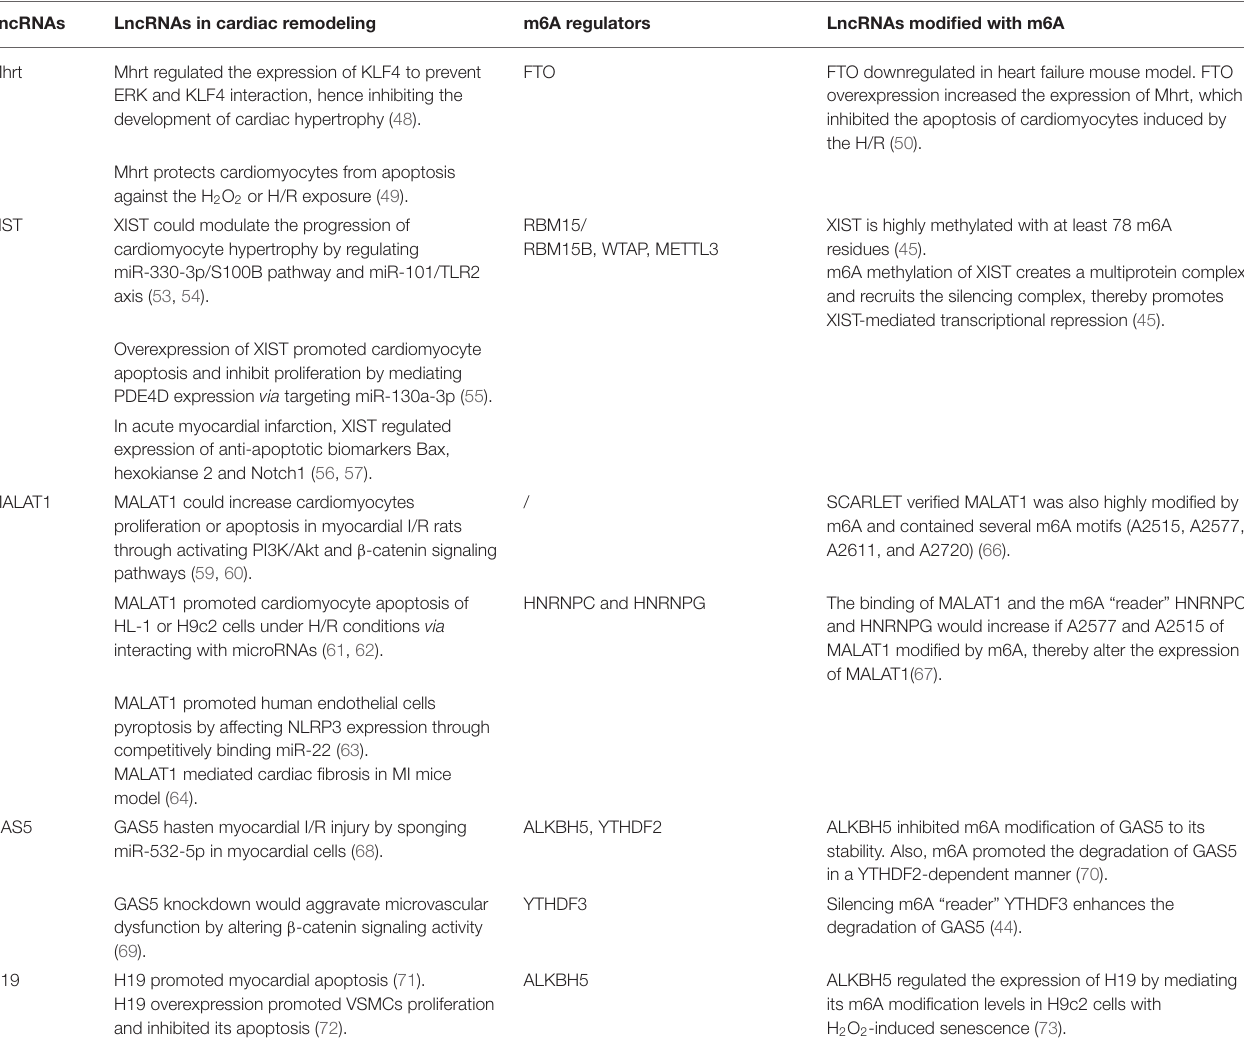
TABLE 2 | Potential role of lncRNA m6A modification in cardiac